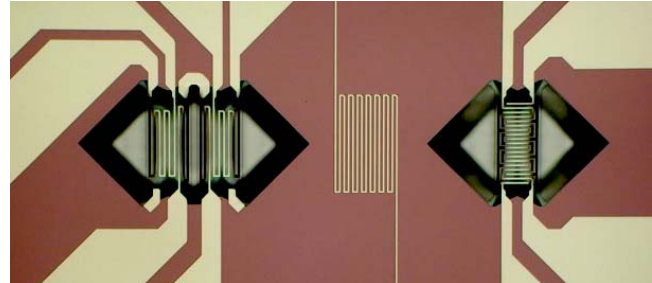
Figure 1. Image of the multiparametric sensing platform showing, from left to right, the anemometric transducer, the thermometer, and the gas sensor (the sensing layer is not present yet). Metal parts and dielectric parts appear with lighter and darker colors, respectively. Micromachining process adopted front-side etching approach, leading to suspended structures with “bridge” shapes. Black parts are the regions where silicon has been removed generating the bridges, while “lighter triangles” appearing at bridge sides are just optical effect: they also are etched regions. The overall size of the platform is about 3 × 5 mm 2